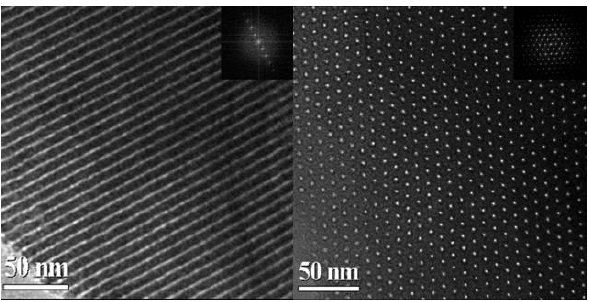
Figure 1. TEM images of the mesoporous carbon FDU-15.